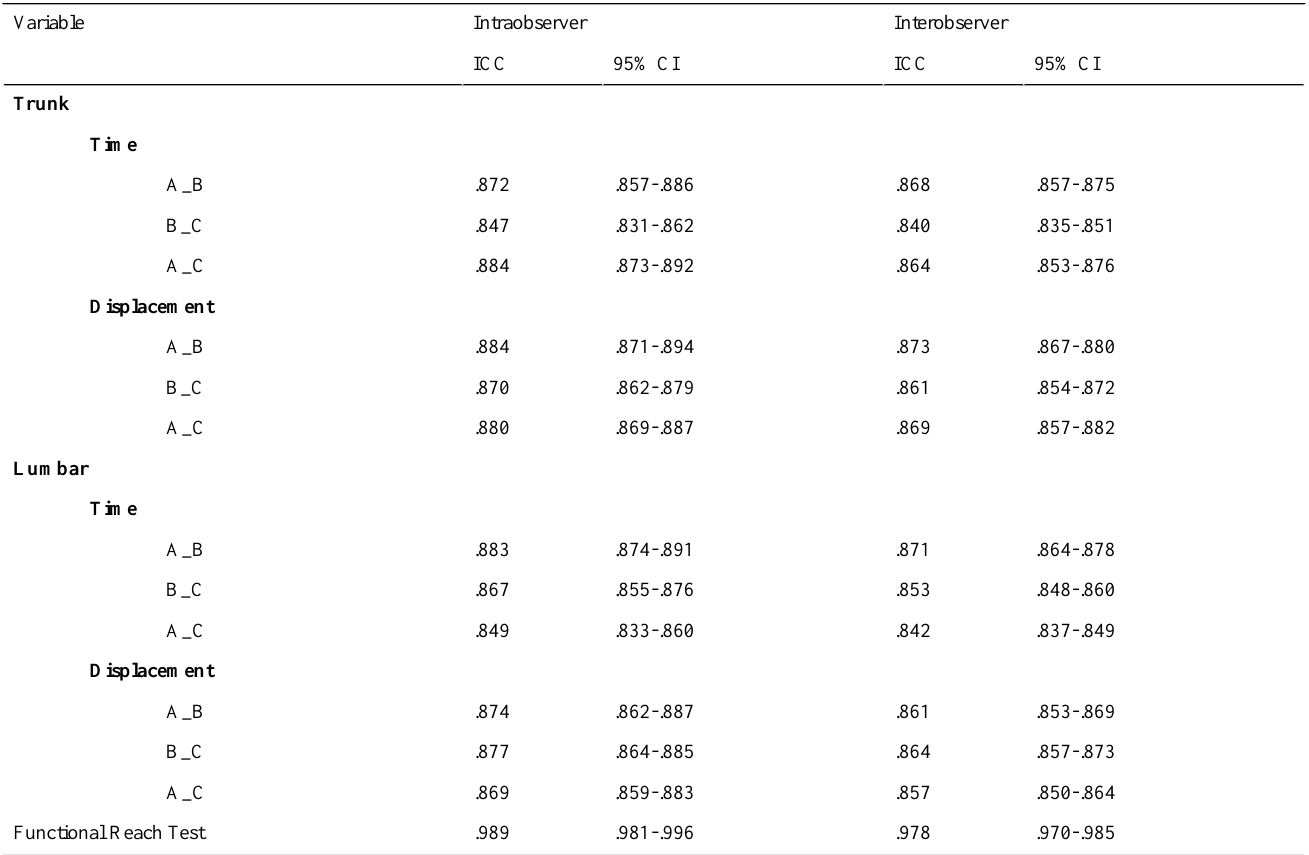
Table 4. Intraobserver and interobserver reliability of variables measured directly during FRT.